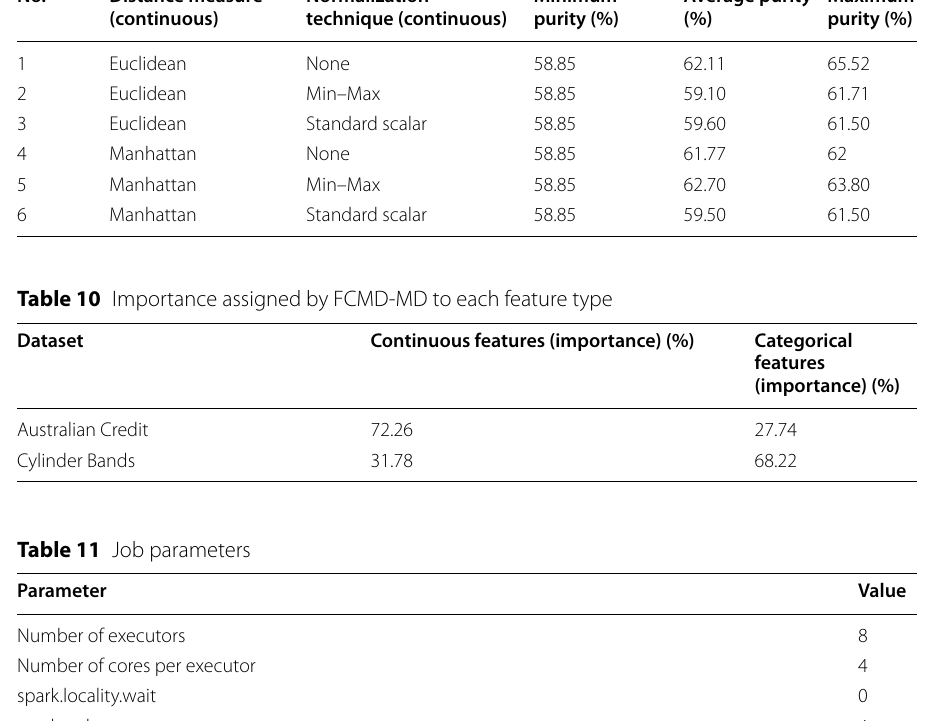
Table 9 Results of different experiment of FCMD-MD on Cylinder Bands dataset No.